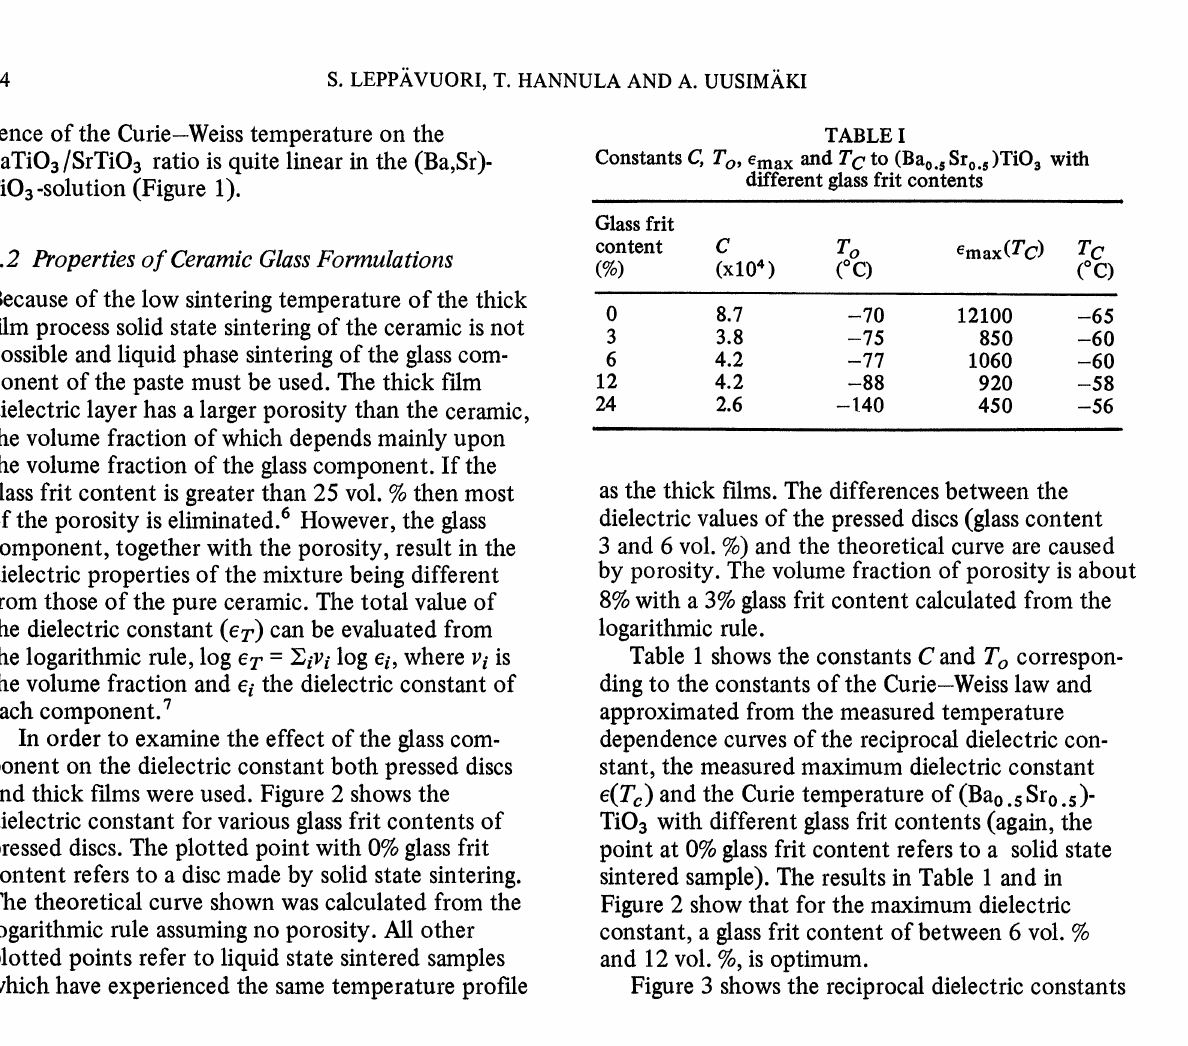
TABLE Constants C, To, ema x and T C to (Bao. Sro. )TiO with different glass frit contents